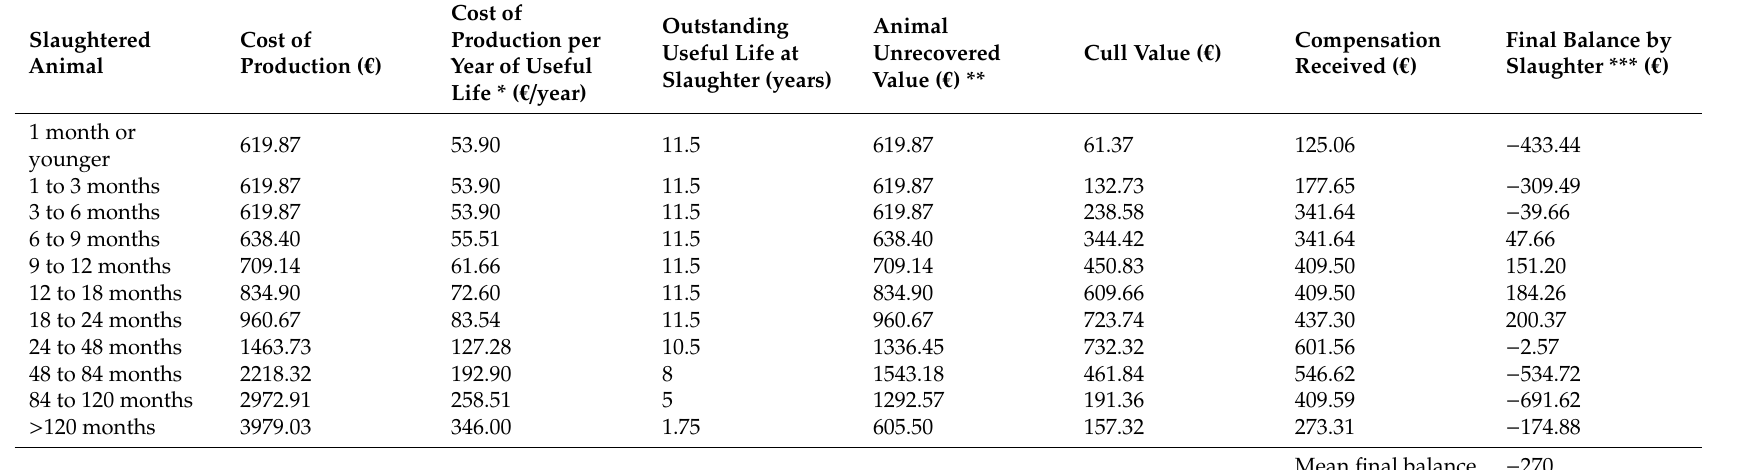
Table 4. Unrecovered value, cull value, compensation received, final balance due to slaughter for each age category and mean final balance.